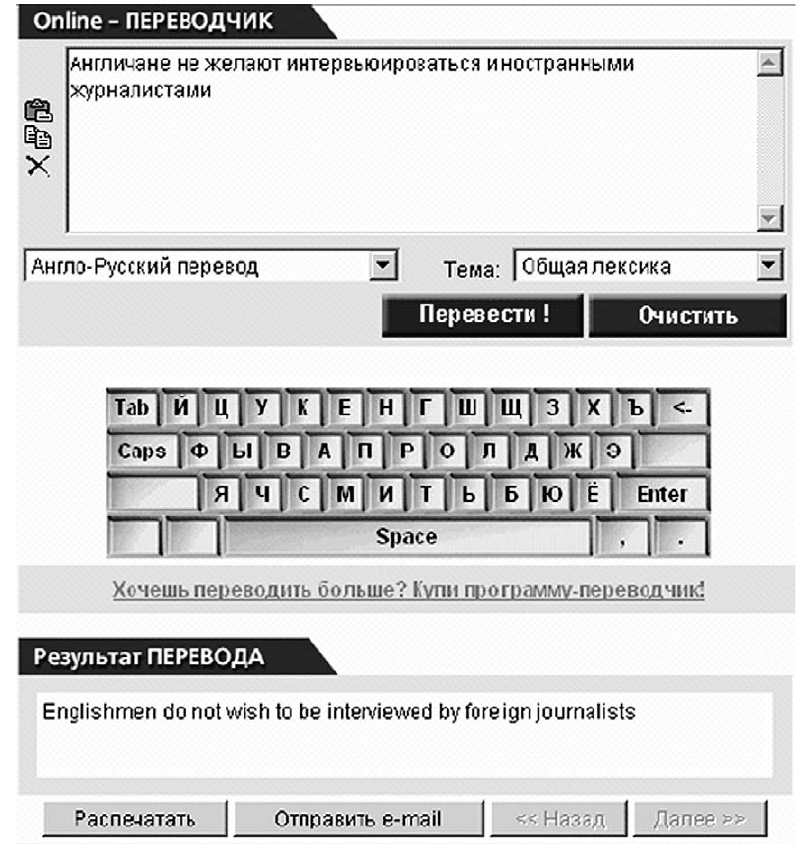
Figure 5. Screenshot of translation